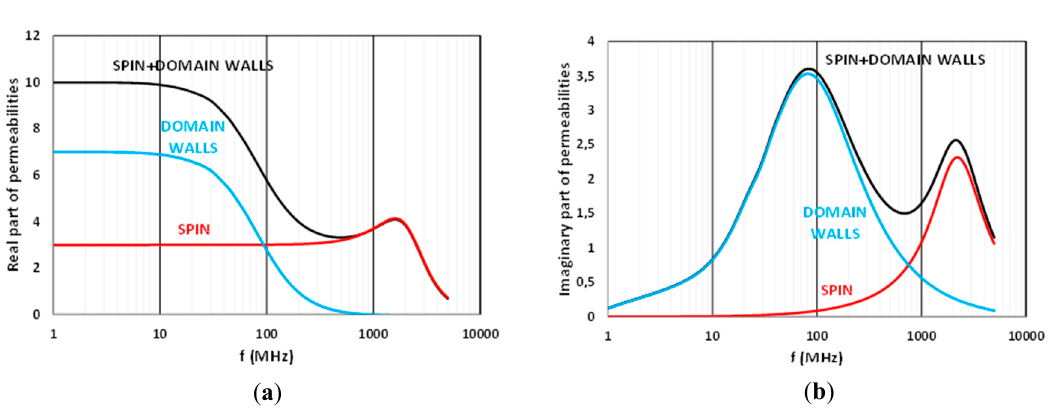
Figure 2. Walls displacements and spin gyroresonance contributions to the complex permeability µ = µ'-jµ'' of a polycrystal of infinite size (a) Real part µ' and (b) Imaginary part µ'' .